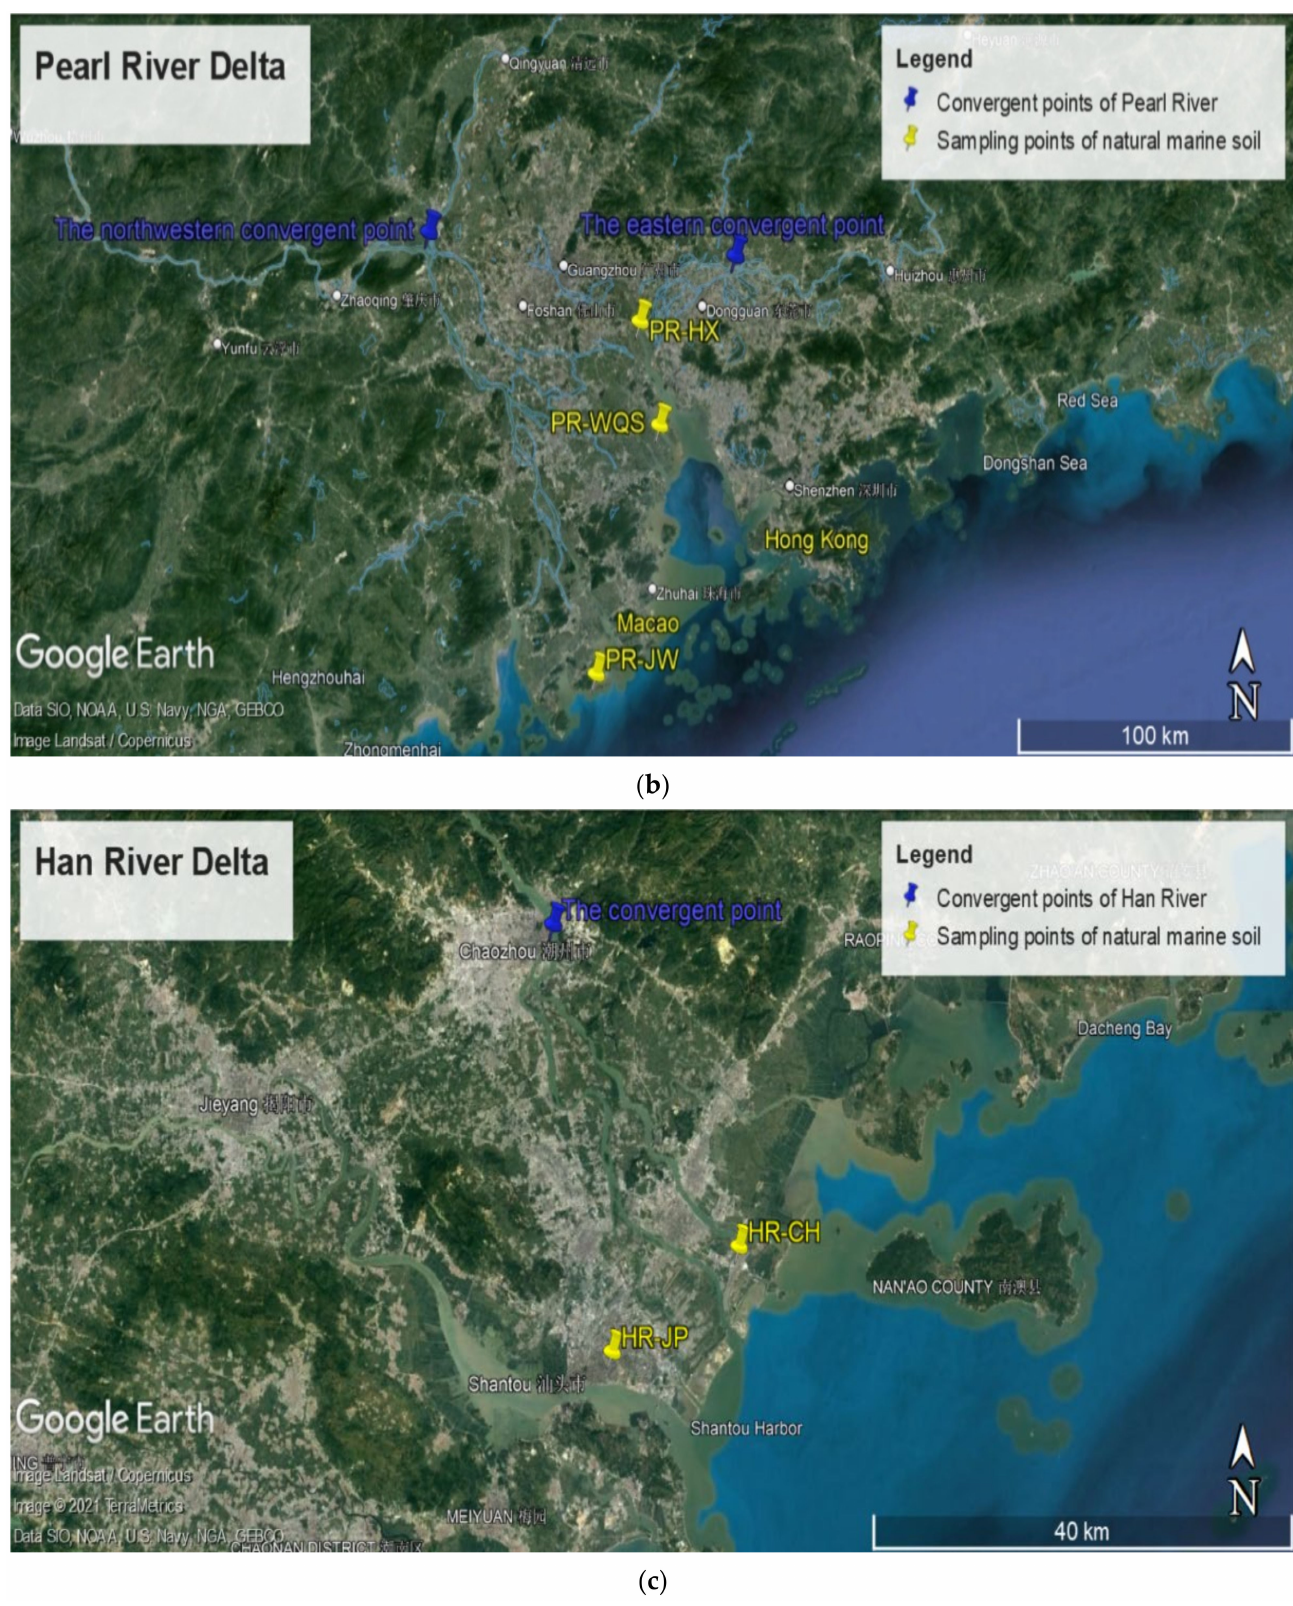
Figure 1. Geomorphologic maps and sampling locations of two typical estuarine deltas in the South China Sea. ( a ) Geomor- phologic map of the southeastern coast of China; ( b ) Geomorphologic map and sampling locations of the Pearl River Delta; and ( c ) Geomorphologic map and sampling locations of the Han River